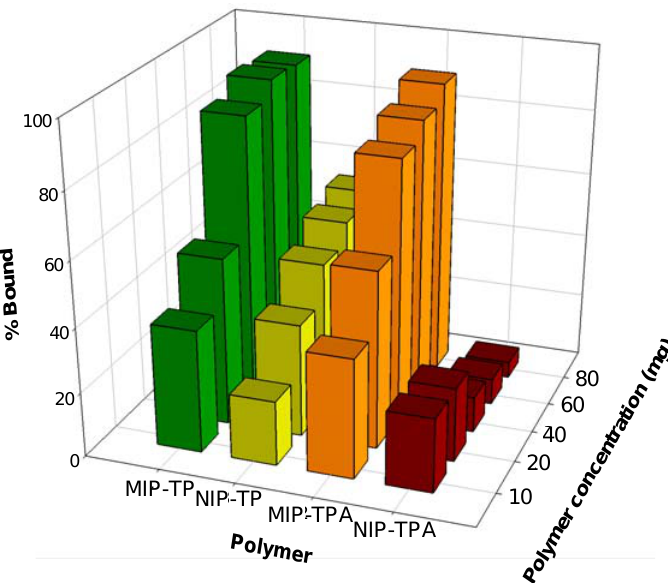
Figure 3. Rebinding analysis of imprinted and non-imprinted polymers towards its respective template